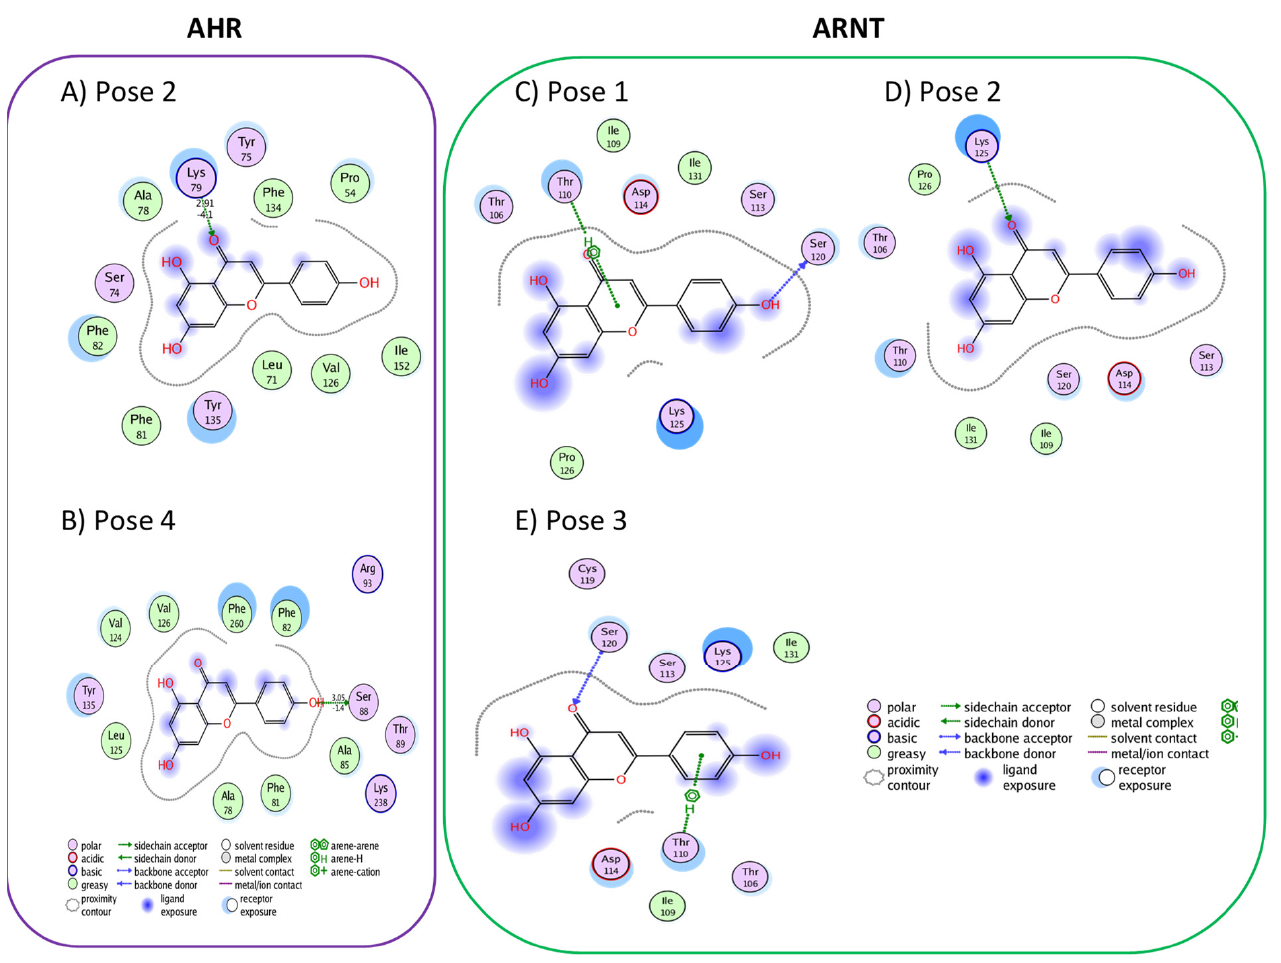
Figure 9. Interaction network between monomeric protein AHR, ARNT and the studied compound 4 .